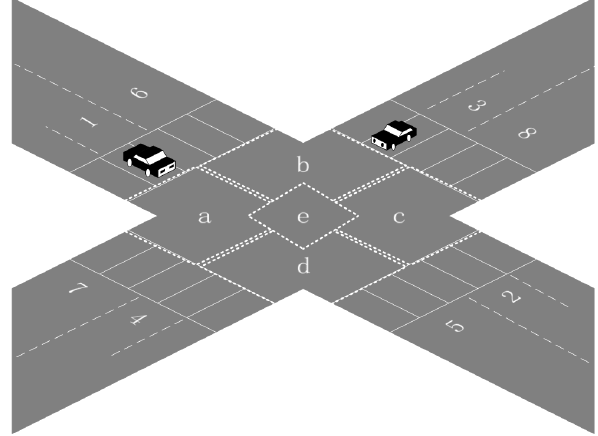
Figure 5. An unsignalized intersection. Table 1. Types of vehicles.